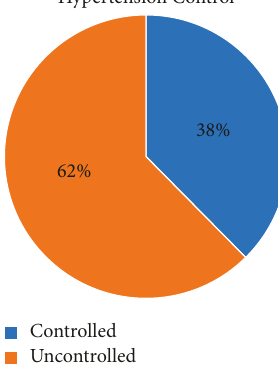
Figure 1: Prevalence of uncontrolled HTN.